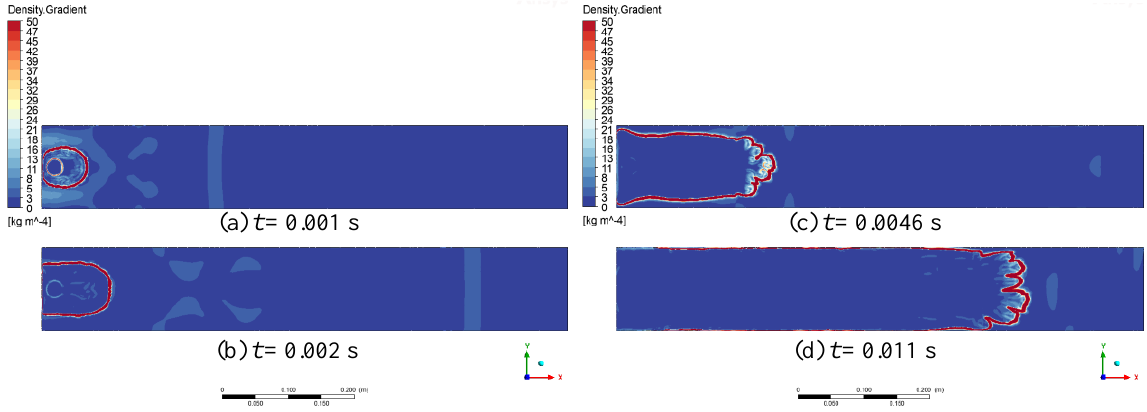
Figure 7. Results of the density gradient for the stoichiometric mixture during flame propagation.